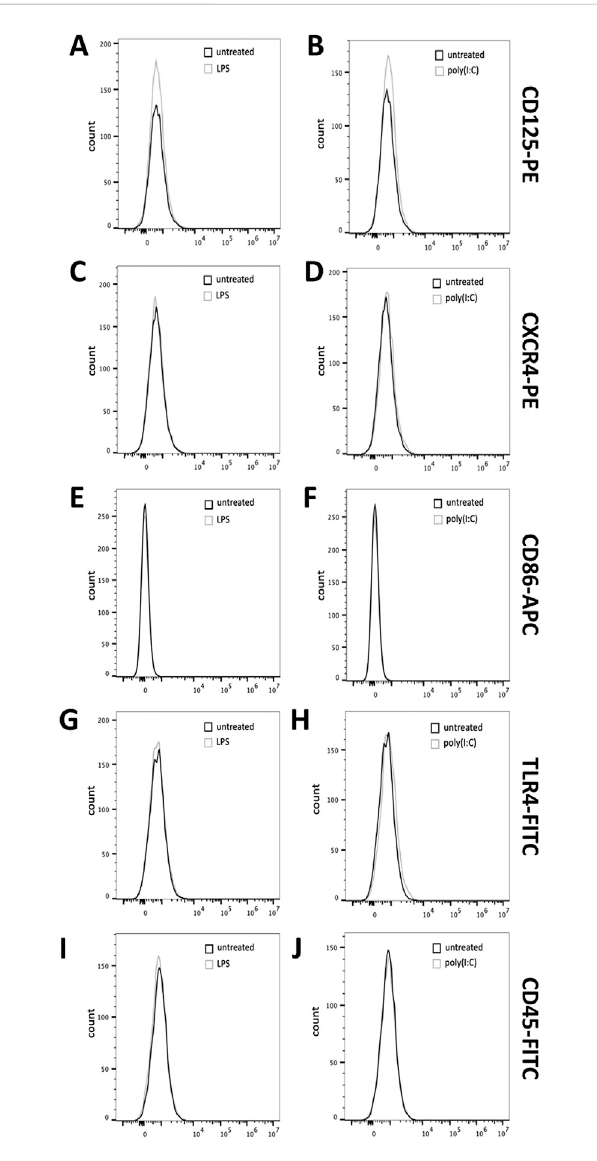
FIGURE 3 HMC3 microglial receptor expression after stimulation with LPS or poly(I:C). HMC3 were stimulated with 1 μ g/mL LPS or 0.5 μ g/mL poly(I:C) for 24 h, and expression of (A, B) CD125-PE, (C, D) CXCR4- PE, (E, F) CD86-APC, (G, H) TLR4-FITC or (I, J) CD45-FITC was analyzed by fl ow cytometry. Data shown is representative of three independent experiments ( n =